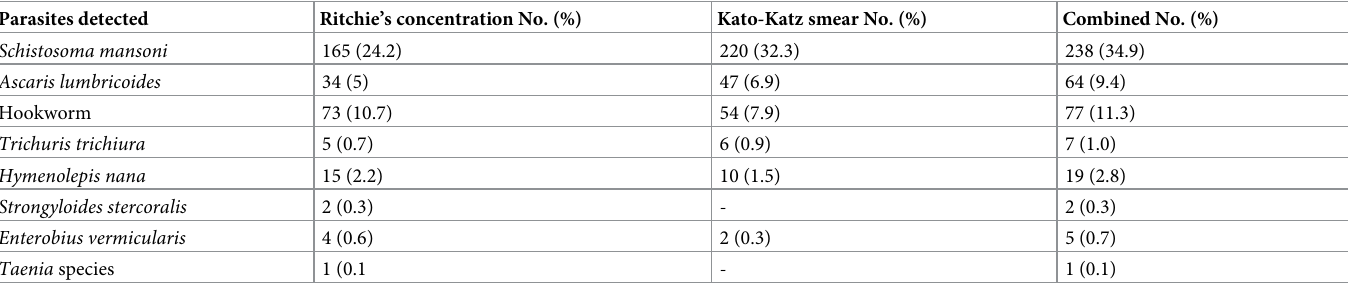
Table 3. Prevalence of Schistosoma mansoni and other helminths among schoolchildren obtained using Kao-Katz and Ritchie’s concentration techniques around Lake Tana, northwest Ethiopia, 2021. Parasites